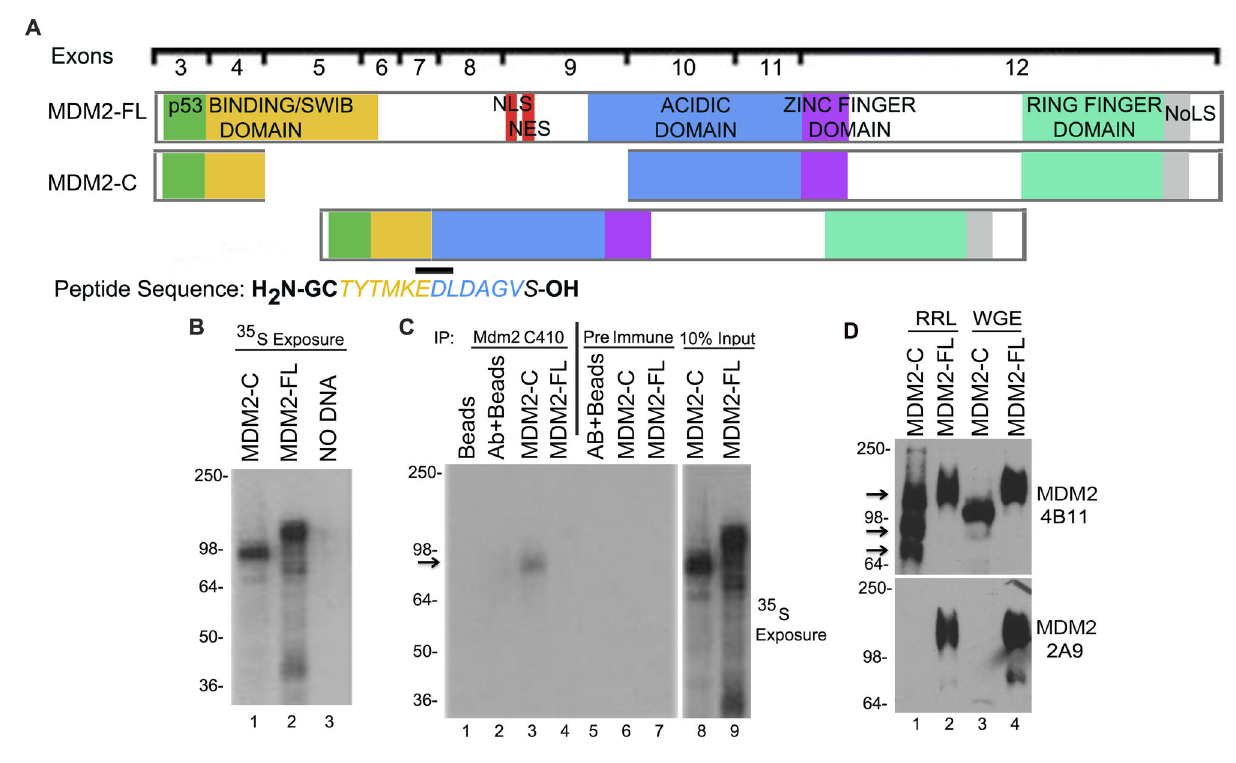
Figure 2. An MDM2-C specific antibody named C410, detects the MDM2-C protein. A . Schematic of full length MDM2 (MDM2- FL) and MDM2-C. The retained proteins’ biochemical functional domains are shown as color codes. The peptide sequence used as an immunogen containing the splice junction of human MDM2-C is shown. Glycine (G) and Cysteine (C) residues were added to the N-terminus of the peptide to facilitate conjugation to an immunoreactive protein, keyhole limpet hemocyanin (KLH). B . 35 S methionine was used as a radioactivity source to label in vitro translated proteins. In vitro translations of pcDNA3-mdm2-FL and pcDNA3-P2mdm2-C using the TNT coupled wheat germ extract system. Resulting MDM2-FL and MDM2-C protein were electrophoresed on a10% SDS-PAGE in a 5:1:1 ratio. The gel was transferred to a nitrocellulose membrane and exposed to film for significant MDM2-C protein product detection. Wheat germ lysate without DNA was used as a negative control. C . Immunoprecipitation of 35 S methionine radioactive-labeled in vitro translated MDM2-FL and MDM2-C proteins using MDM2 C410 and pre-immune polyclonal serum antibodies. Protein ratios as shown in B were used in the pull down assay. Samples were electrophoresed on a 10% SDS-PAGE gel transferred to a nitrocellulose membrane and exposed to film for protein detection. This is representative of three independent experiments. D. In vitro translated protein made in rabbit reticulocyte lysate (RRL lanes 1 and 2) were compared to protein translated in wheat germ extract (WGE lanes 3 and 4). These proteins were detected with either antibody 4B11 (top panel) or 2A9 (bottom panel). HRP- conjugated anti-mouse and anti-rabbit were used as secondary